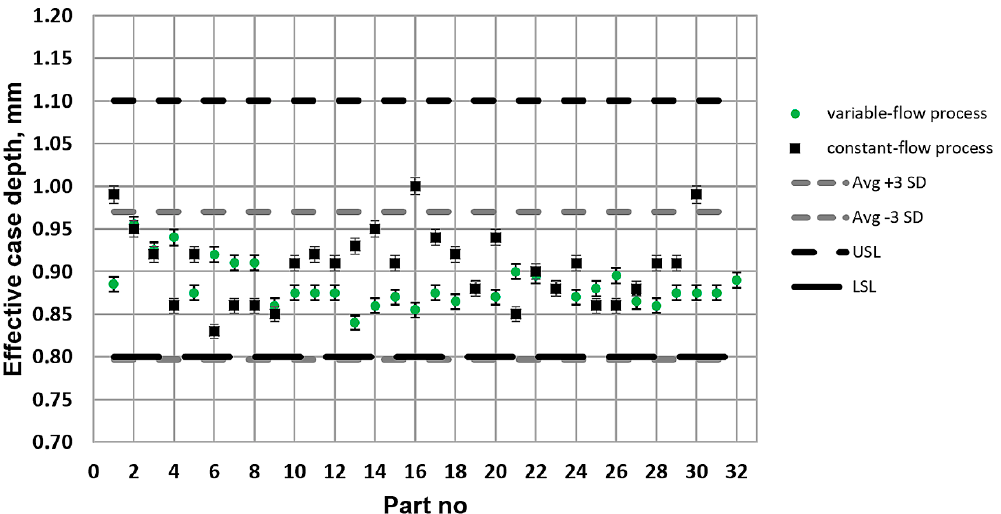
Figure 4. Surface hardness of parts resulting from variable-flow and constant-flow processes (LSL, USL—lower and upper specification limit).